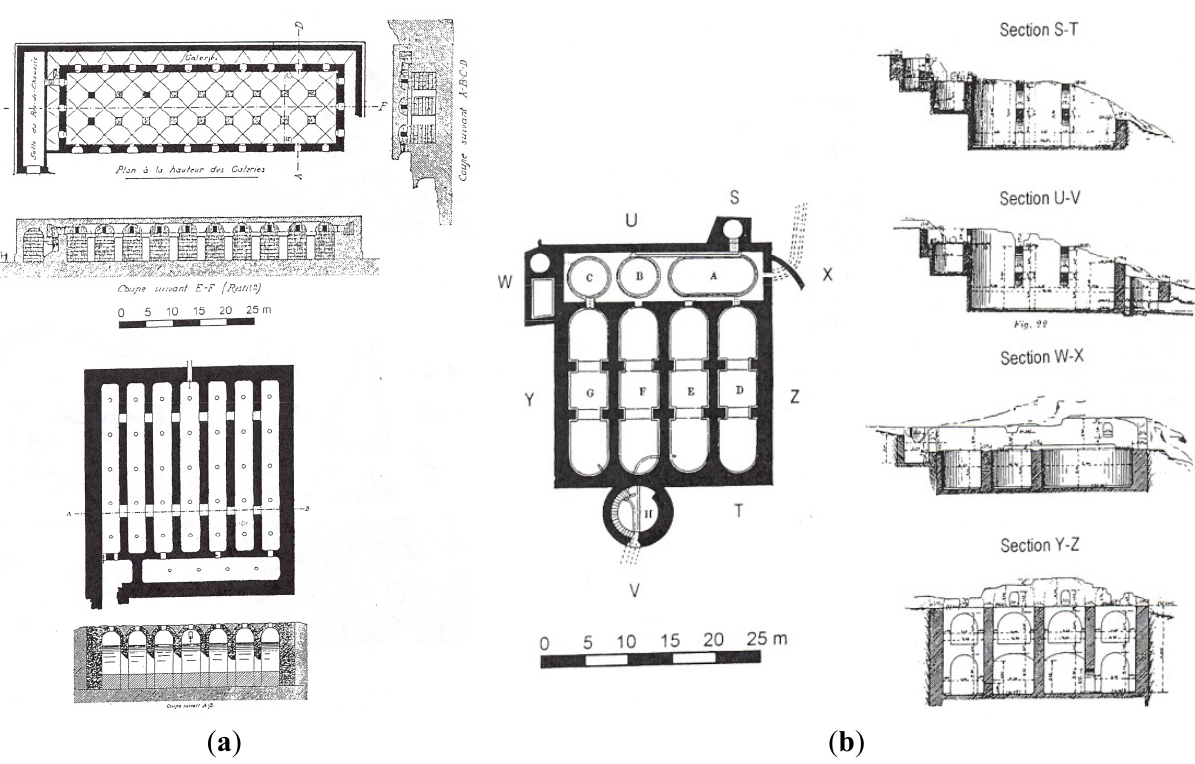
Figure 10. Cisterns in North Africa: ( a ) plans and sections of the small (top) and large (bottom) cisterns at Uthina (Oudna, Tunisia) (after Babelon and Cagnat [21], text to f.XXVIII, Oudna) and ( b ) cisterns at Dar Saniat at Carthage (after Cagnat and Chapot, [22,23]. Both (a) and (b) as presented in [20]). Water also flowed from settling tank A into secondary circular settling tanks B and C before entering the second cistern chambers F and G. The water in F and G obviously would have been cleaner. A circular tap chamber (H in Figure 10b) received water through two lead pipes from D and E at floor level. It also received the higher quality water from G and F in a third lead pipe a meter higher than floor